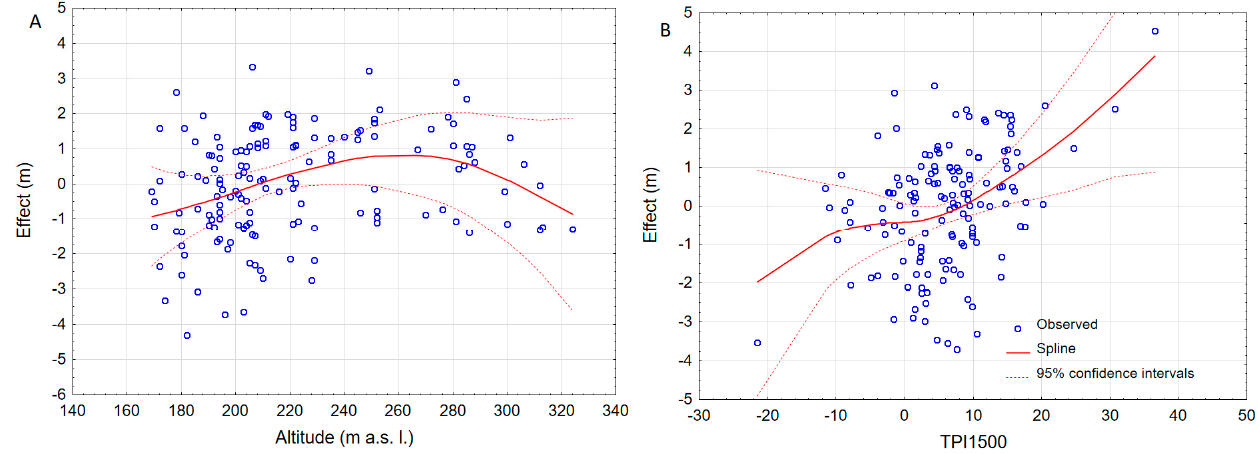
Figure 6. Partial effects of altitude ( A ) Topographic Position Index in neighbor scales of 1500 ( B ) on the site index for oak. The effect altitude and Topographic Position Index change is displayed with all other factors held constant.